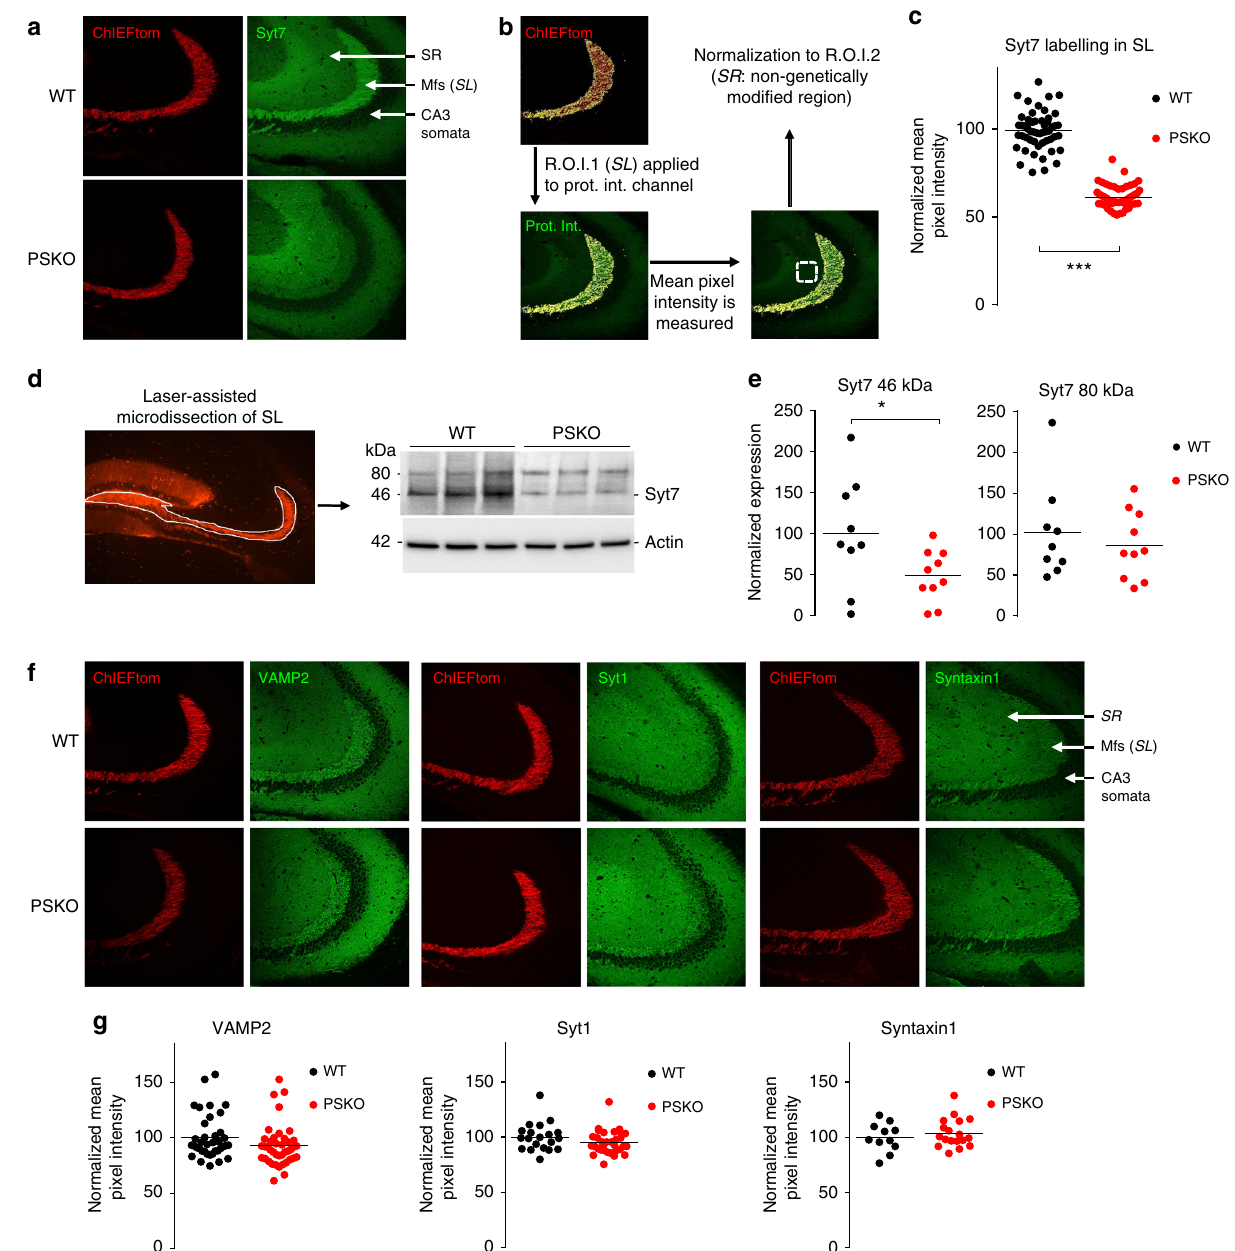
Fig. 3 PS supports the presynaptic expression of Syt7. a Confocal images of the stratum lucidum ( SL ) where the Mfs can be distinguished in the red channel (ChIEFtom) and stainings of Syt7 depicted in green. Syt7 staining in PSKO Mfs was negligible in comparison to WT. The phenotype presented here using antibody 105173 from Synaptic System is reproduced in Supplementary Fig. S3d with the antibody N275/14 from Millipore. b To quantify the intensity of the stainings a mask corresponding to the SL was created in the red channel. This fi rst region of interest (ROI) was applied to the green channel were the mean pixel intensity of the protein of interest was measured only in the SL . To normalize the results, the mean pixel intensity was also measured in a second ROI: the stratum radiatum ( SR ). The staining intensities in the SL were normalized to the intensities in the SR . c Scatter plots of the mean pixel intensity in the SL normalized to the mean pixel intensity in the SR . A reduction of 40% of intensity is observed while approximately half of the Mfs are projected from PSKO GCs. n = 53 slices from nine mice in WT, n = 50 slices from eight mice in PSKO, p = 0.0004. d Confocal image of the hippocampus depicting the area dissected with a laser to prepare protein lysates, and western blot from these lysates showing a decreased expression of Syt7. e Quantitative analysis of western blot in c . A 50% decrease in the expression of the 46 kDa band of Syt7 was detected. f Confocal images of the stratum lucidum ( SL ) where the Mfs can be distinguished in the red channel (ChIEFtom) and stainings of VAMP2, Syt1 or Syntaxin1A are seen in green. g Scatter plots of the mean pixel intensity in the SL normalized to the mean pixel intensity in the SR measured in images as in e . Staining patterns and intensities do not differ between genotypes. For VAMP2, n = 38 slices from eight mice in WT, n = 41 slices from nine mice in PSKO. For Syt1, n = 20 slices from fi ve mice in WT, n = 33 slices from seven mice in PSKO. For Syntaxin1, n = 11 slices from four mice in WT, n = 18 slices from seven mice in